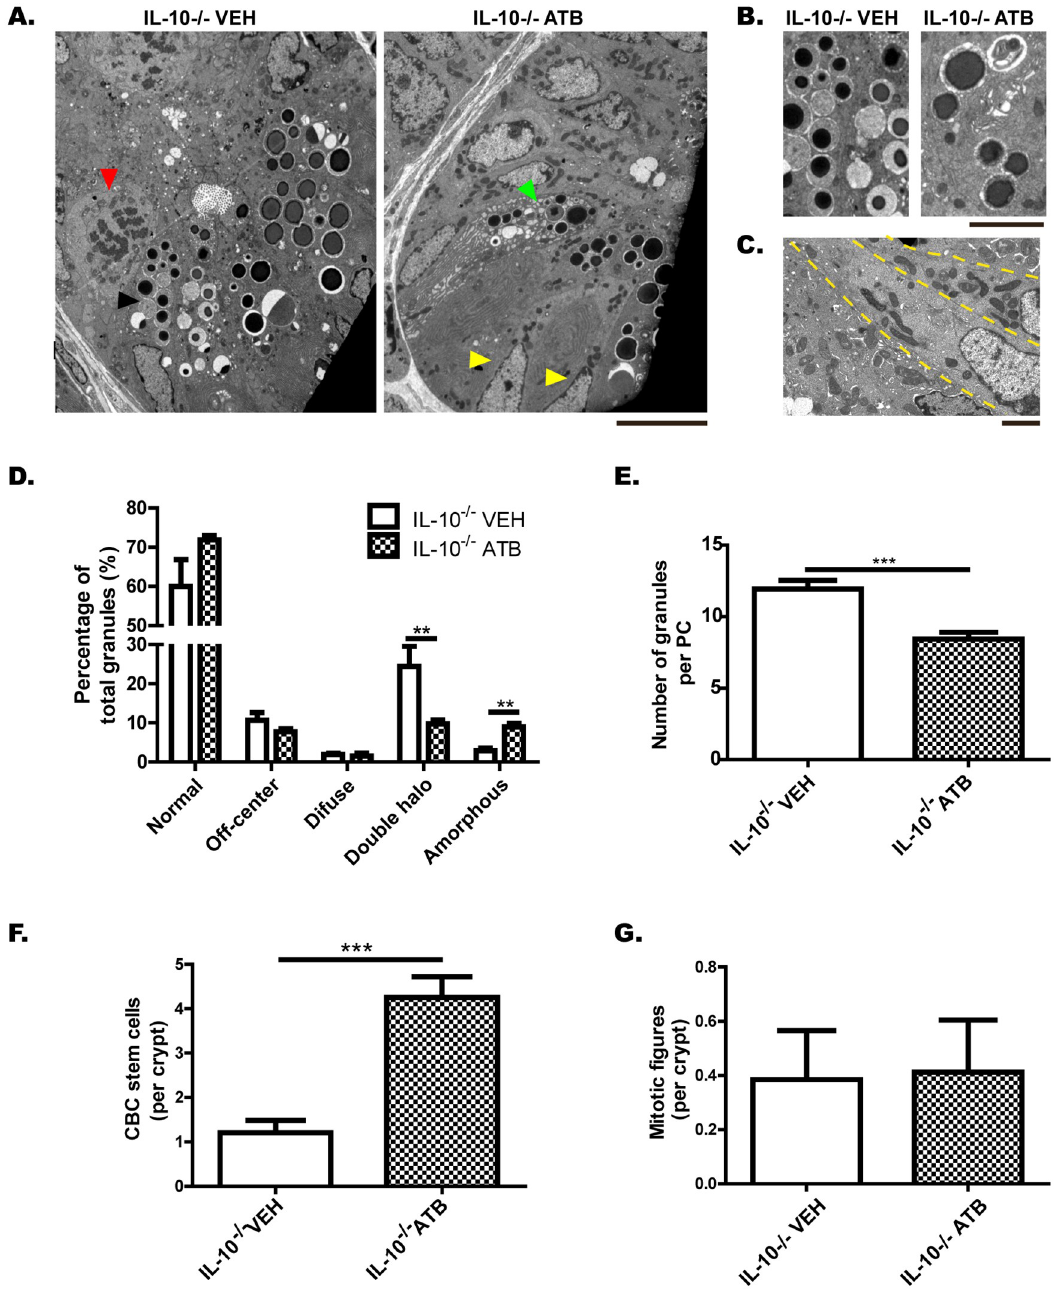
Fig 7. Depletion of gut microbiota partially improves the Paneth cells phenotype, but does not normalize the state of the crypt. (A) Ileum crypts of IL-10 -/- mice treated with vehicle (IL-10 -/- VEH) or broad-spectrum antibiotics (IL-10 -/- ATB), evaluated by transmission electron microscopy (scale bar is 10 μ m). Black arrow shows a PC with double-halo granules, green arrow shows a PC with amorphous granules, yellow arrows show Crypt Base Columnar (CBC) stem cells and red arrow show a mitotic figure. (B) Representative images of PC granules from both groups (scale bar is 5 μ m). (C) Crypt Base Columnar (CBC) stem cells of a IL-10 -/- ATB mouse, with large amounts of mitochondria in their cytoplasm (scale bar is 2 μ m). D) Classification of granules according to their TEM morphology in: normal, off-center, diffuse, double halo and amorphous (n = 3 mice, 2-way ANOVA, post-hoc Bonferroni � p<0.05). E) Number of granules per PC (t-student, ��� <p 0.001). F) Number of CBC stem cell per crypt (t-student, ��� <p 0.001). G) Number of undifferentiated cells in mitotic phase per crypt.